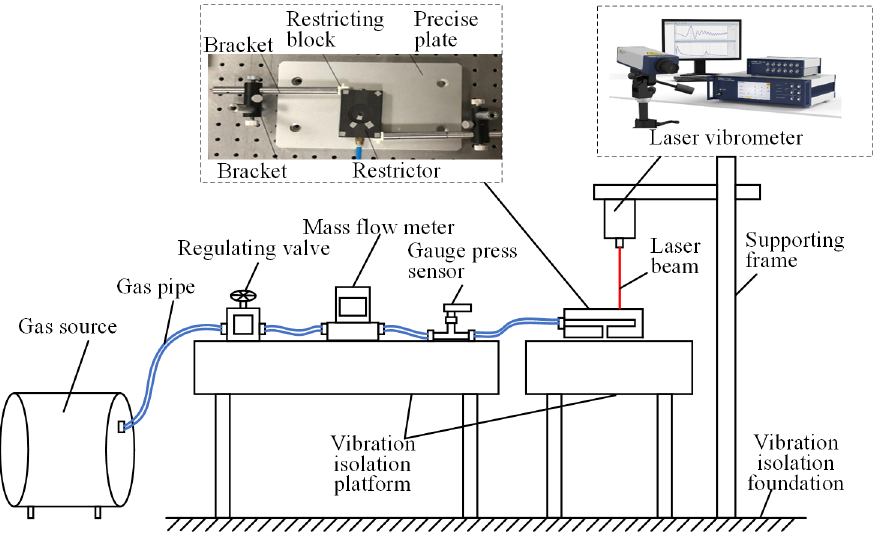
Figure 5. Experimental device with a vibrometer.